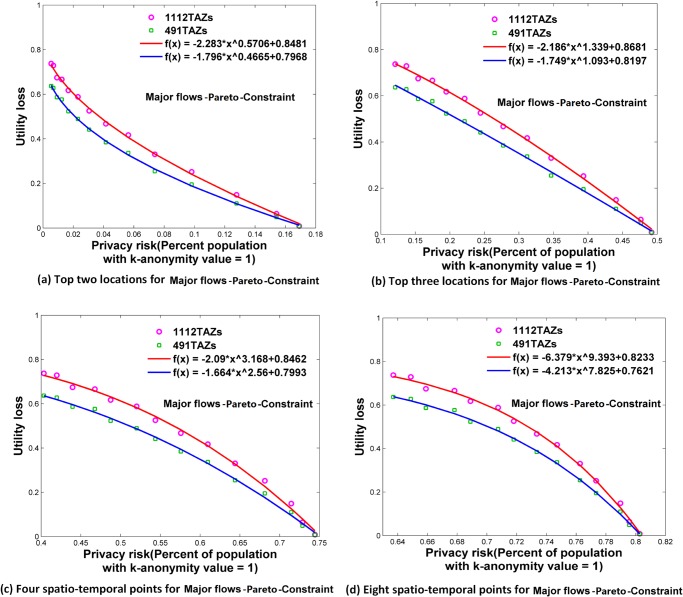
Relationships between privacy risk and data utility using Major flows-Pareto-Constraint.(a) Top two locations. (b) Top three locations. (c) Four spatio-temporal points. (d) Eight spatio-temporal points.